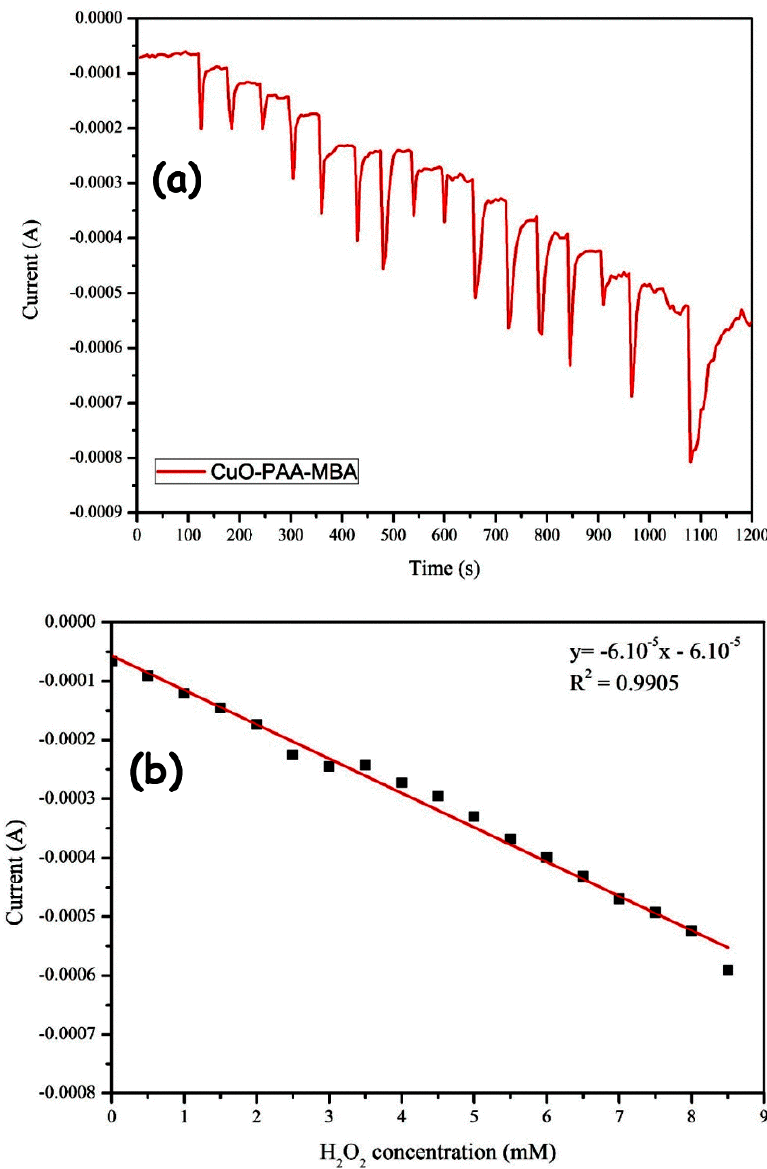
Figure 7. Amperometric response of the CuO–MBA–PAA / ITO electrode by addin H 2 O 2 in 0.1M PBS at − 0.4 V (left side) and the detection calibration curves by adding H 2 O 2 (right